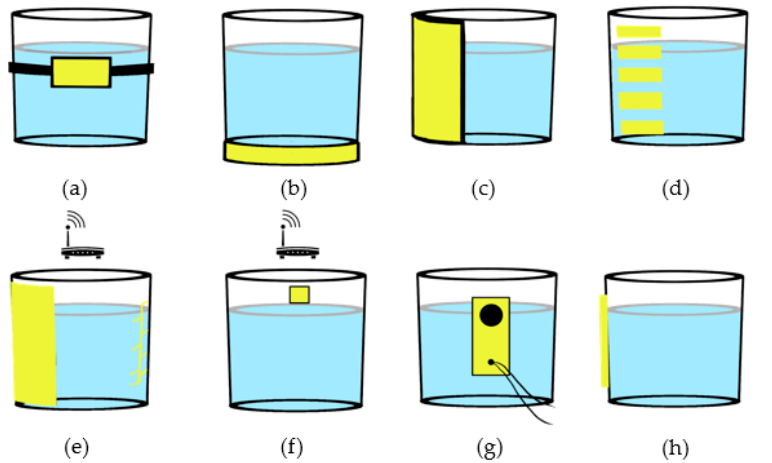
Figure 4. Schematic diagram of various sensor layouts for each smart container category, namely ( a ) inertial [120–124], ( b ) load and pressure [125], ( c ) capacitive [126], ( d ) conductive [127], ( e ) Wi-Fi [128], ( f ) vibration [129], ( g ) acoustic [130], ( h ) and other level sensor [131].